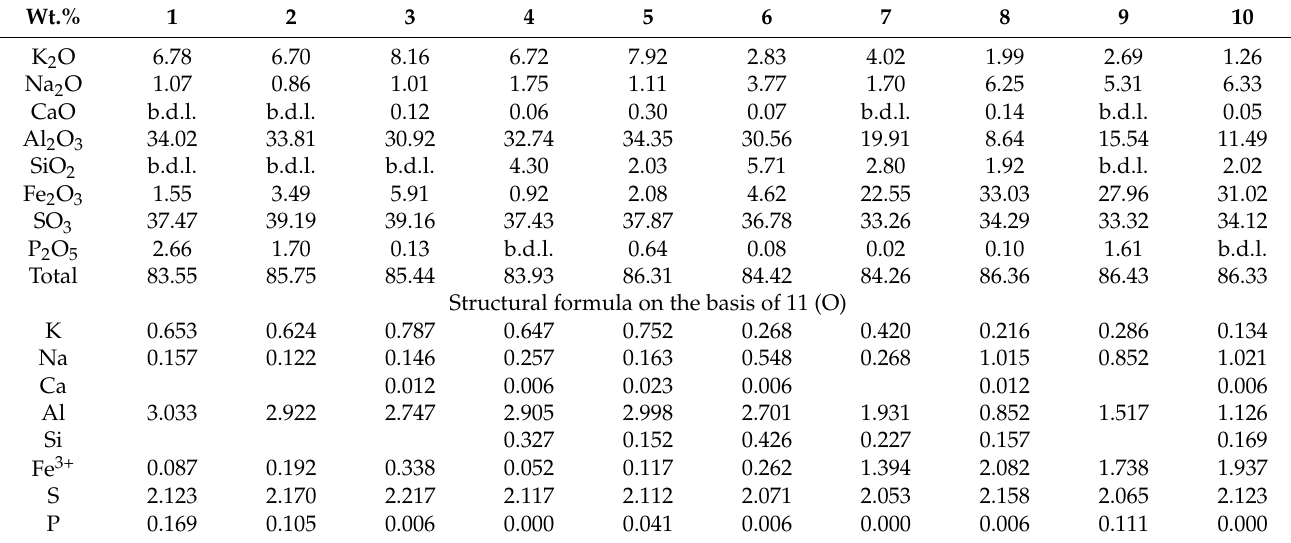
Table 4. Representative microanalyses of alunite (1–5), natroalunite (6), alunite-jarosite solid solution (7), natrojarosite (8–10). Wt.%